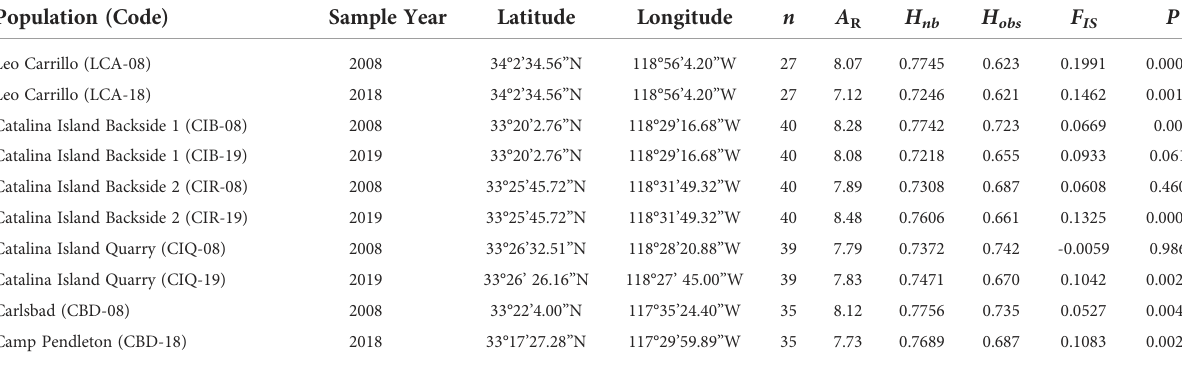
The table includes: population with code, sample year, latitude and longitude, sample size (n), standardized allelic richness (A R ), non-biased expected heterozygosity (H nb ), observed heterozygosity (H obs ), inbreeding coef fi cient (F IS ), Fisher ’ s exact test for Hardy Weinberg equilibrium p value (P). *Bonferonni Correction P B and P: P <